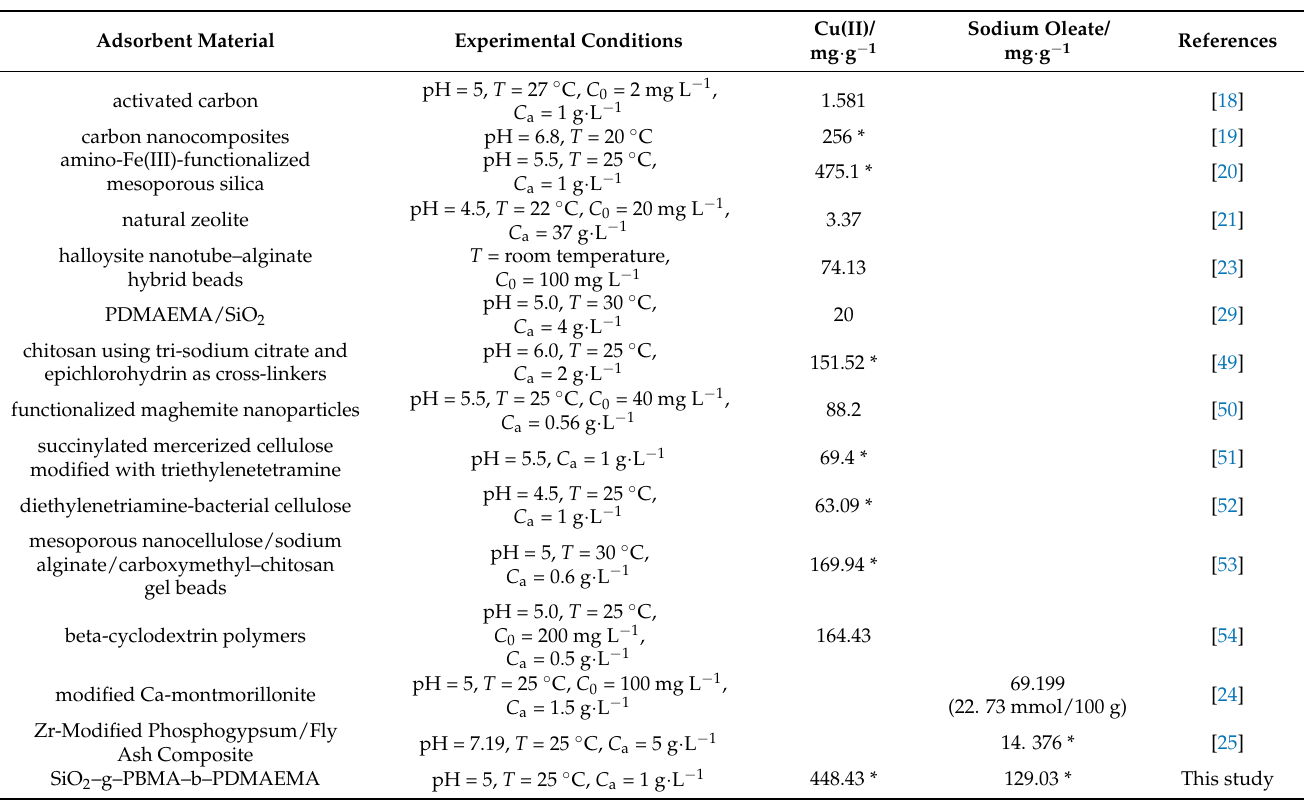
Table 5. Comparison of Adsorption